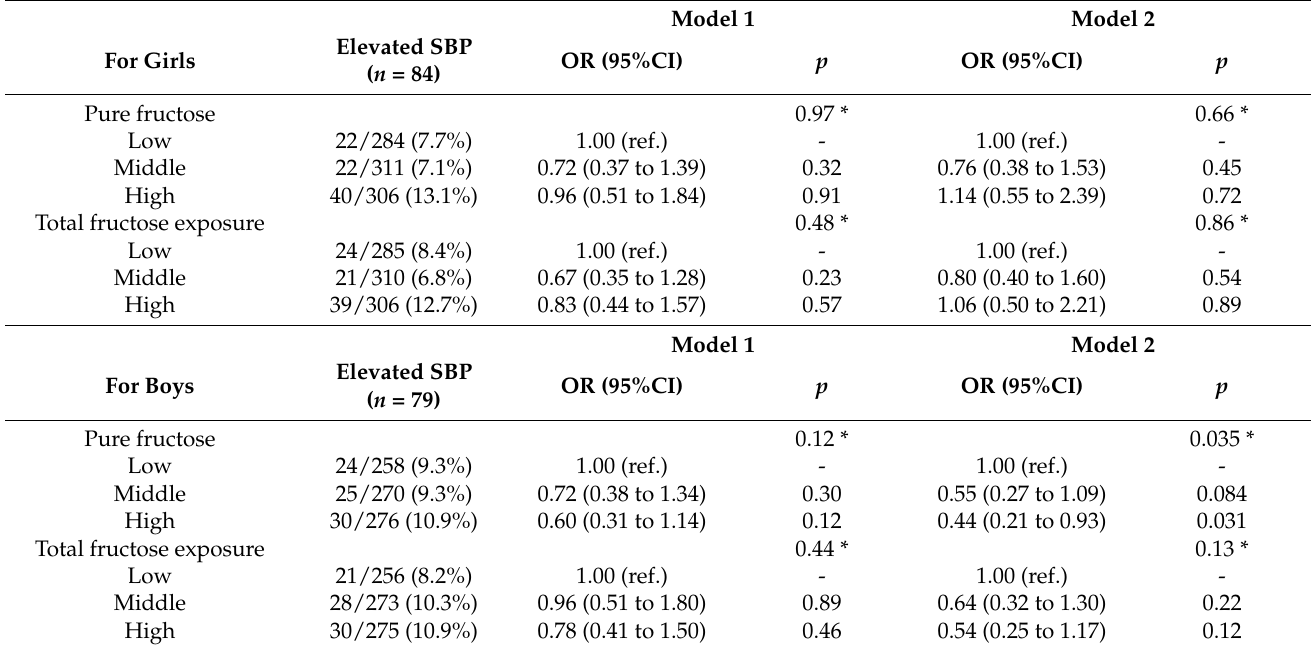
Table 4. Association between elevated systolic blood pressure and pure and total fructose exposure from various fructose- containing foods.